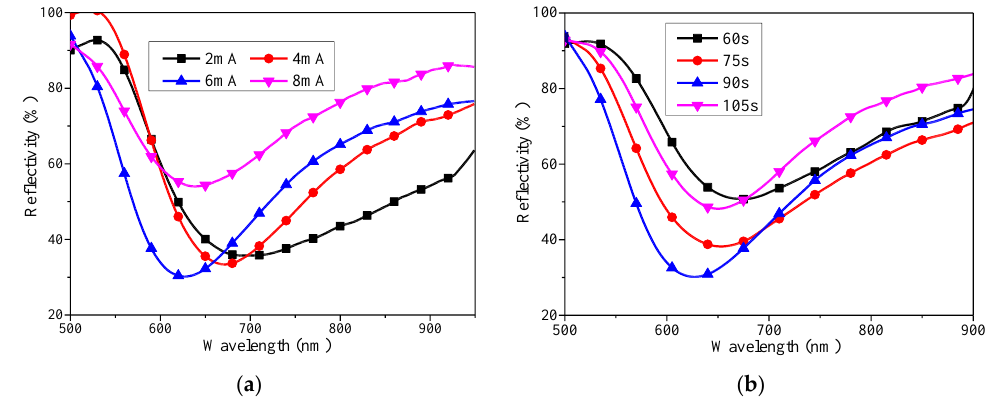
Figure 3. Experimental SPR spectra when the Au film is coated with different coating currents ( a ) and coating times ( b ).